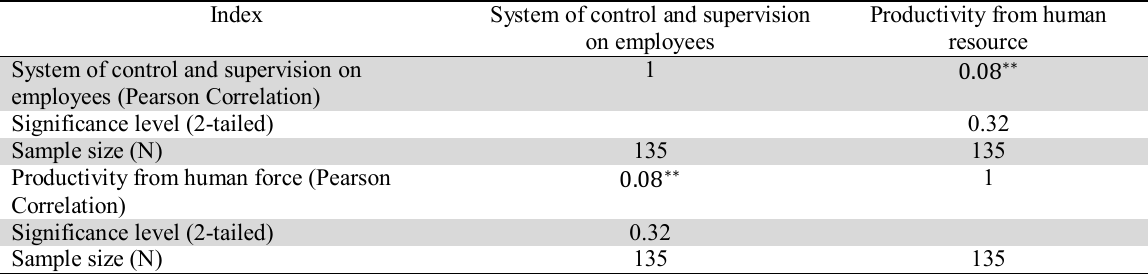
Result from Pearson's test about relationship between system of control and supervision on employees and productivity from human